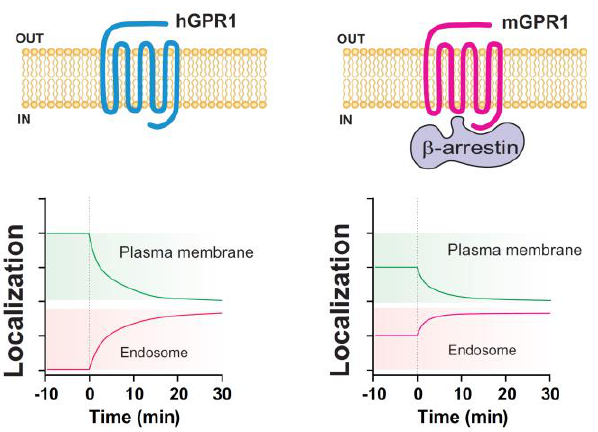
Figure 10. Overview of the main properties of human and mouse GPR1. In basal conditions, human hGPR1 interacts weakly with β -arrestins, whereas its mouse orthologue mGPR1 displays a strong constitutive interaction with β -arrestins. Constitutive interaction of mGPR1 with β -arrestins required different structural constituents, including the receptor C-terminus and arginine 3.50 in the second intracellular loop. hGPR1 is more present at the plasma membrane and less in endosomal compartments, compared with mGPR1. Thus, constitutive interaction of mGPR1 with β -arrestins favors the presence of the receptor in early and recycling endosomes in basal conditions. Both hGPR1 and mGPR1 are progressively relocated from the plasma membrane to early endosomes after chemerin stimulation (t = 0).